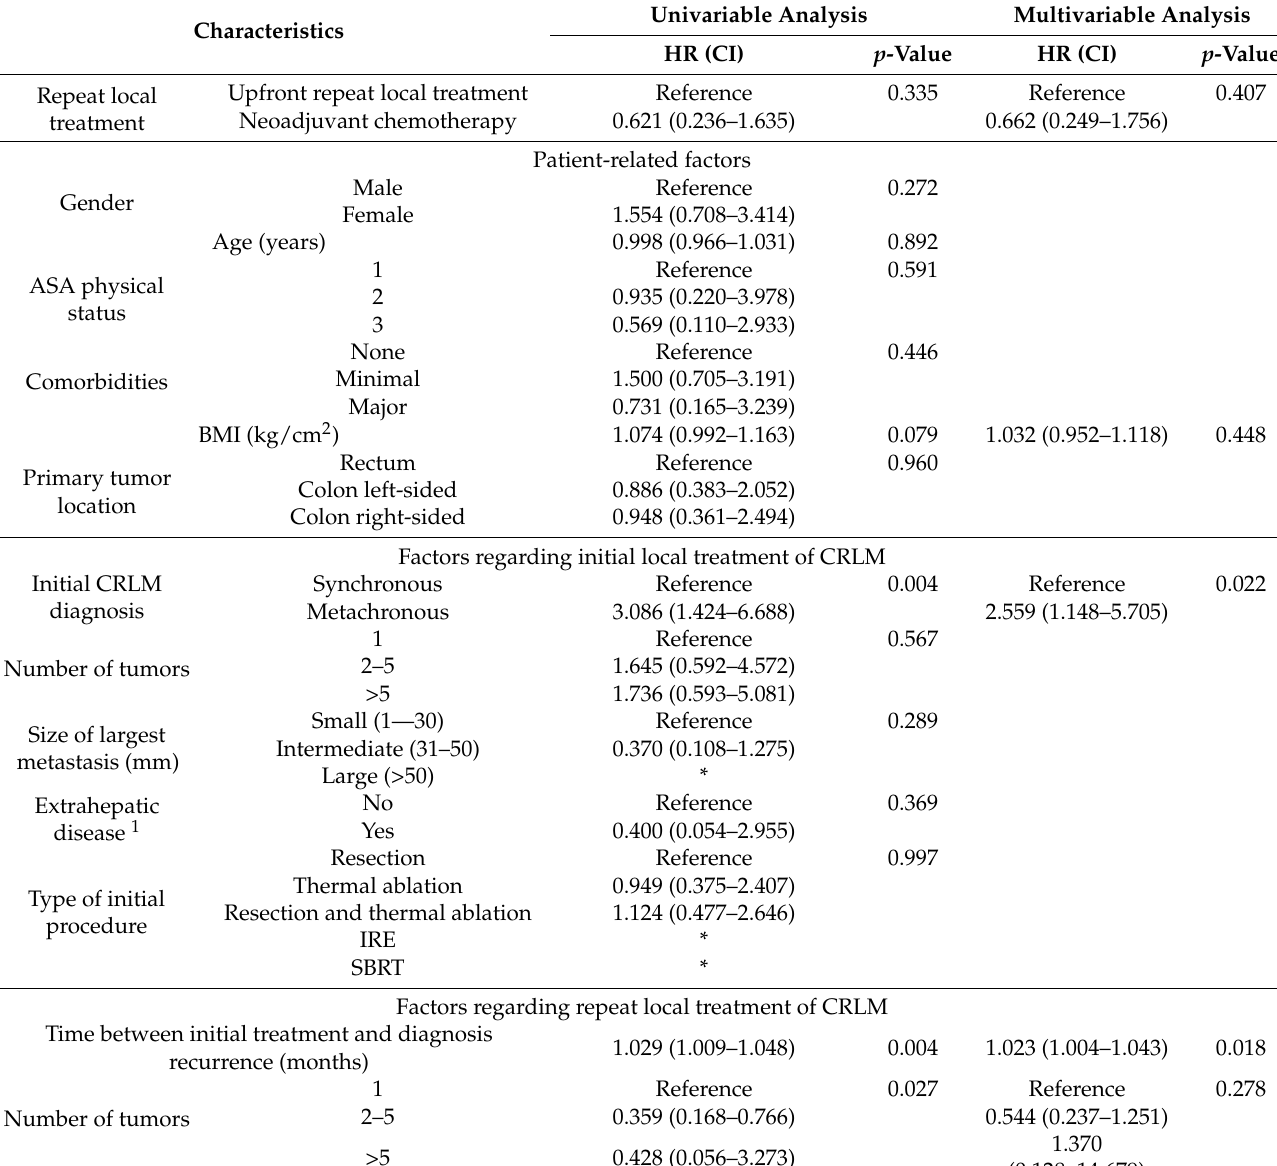
Table 7. Univariable and multivariable Cox regression analysis to detect potential confounders associated with local tumor progression-free survival (LTPFS). After removal of BMI and number of recurrent metastases and adjusting for the confounder time between initial treatment and diagnosis recurrence and initial CRLM diagnosis, corrected HR of